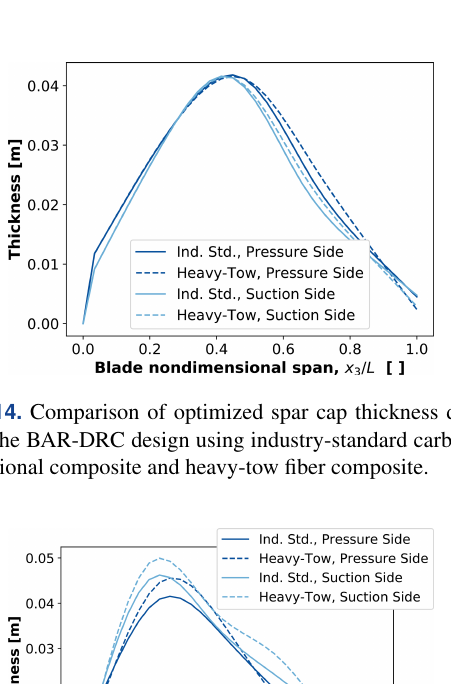
Figure 13. Displacement plot of most critical buckling mode for optimized BAR-URC design viewed from the (a) suction side and (b) trail- ing edge.